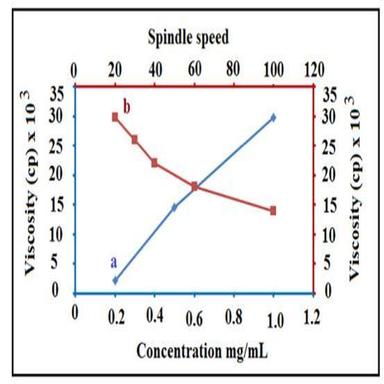
(a) Effect of concentration on viscosity (b) Effect of spindle speed on viscosity.